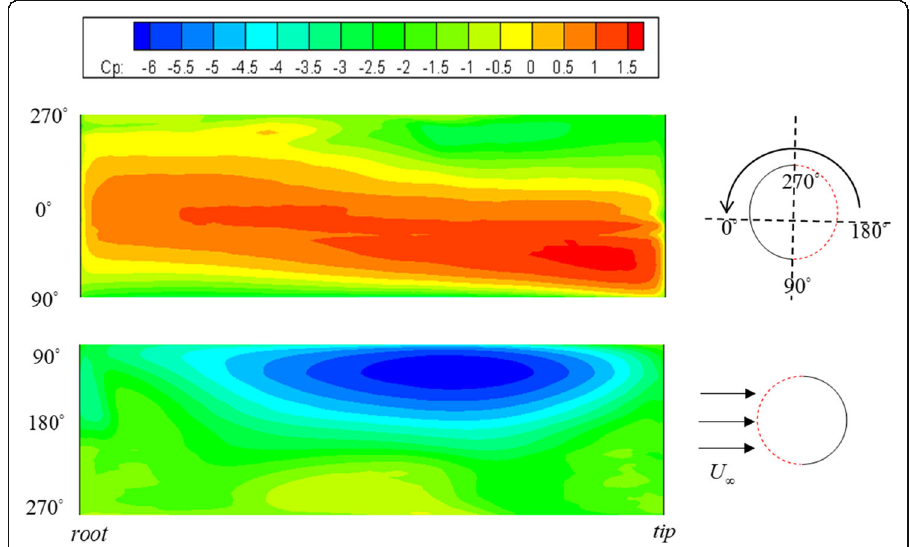
Fig. 10 Contours of dimensionless pressure coefficient on the Magnus blade with AR = 3. The projected surface is denoted by the black solid line